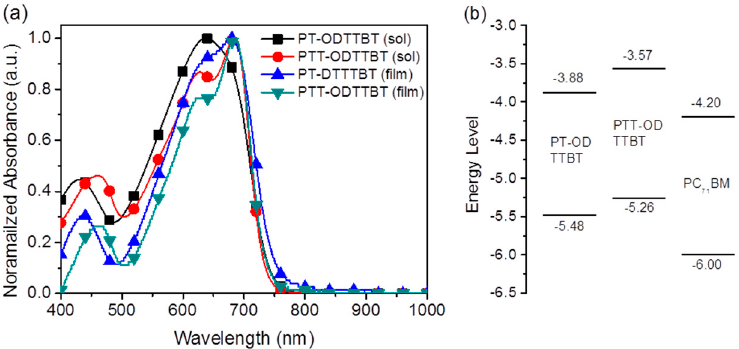
Figure 1. ( a ) Absorption spectra of the copolymers in the solution and thin films. ( b ) Diagram of molecular energy levels for the synthesized polymers and PC 71 BM.